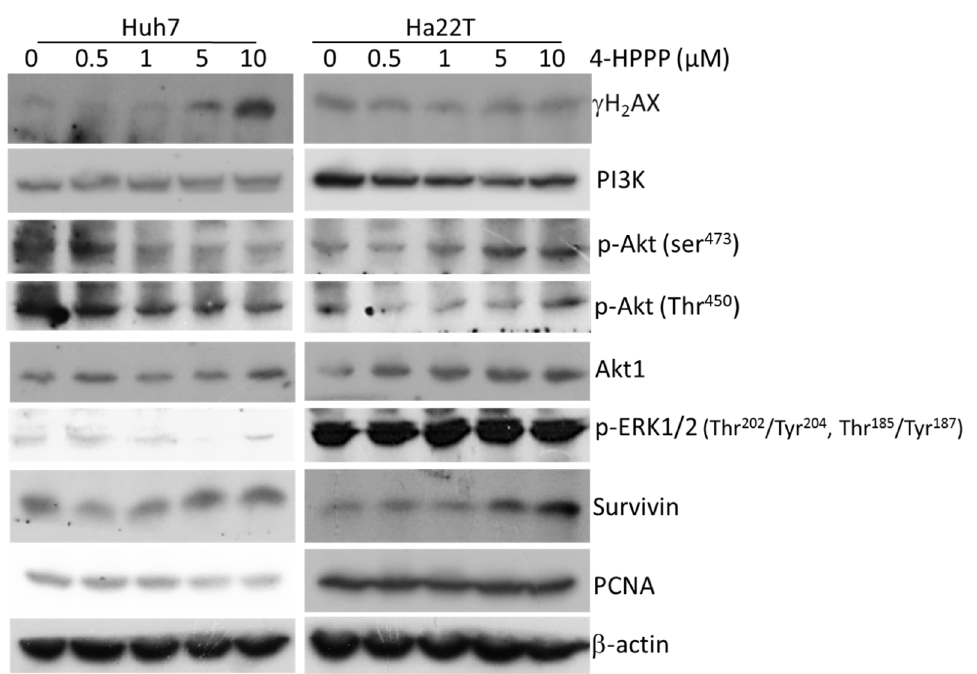
Figure 8. The changes of the survival-related proteins and DNA damage in 4-HPPP-treated HCC cells. Huh7 and Ha22T cells were seeded and treated with indicated concentrations of 4-HPPP for 24 h respectively. Afterward, cells were harvested and lysed. The protein lysates were resolved and analyzed by 10% and 12% sodium dodecyl sulfate-polyacrylamide gel electrophoresis (SDS-PAGE) and Western blot assay respectively. β -actin as an internal control for equal loading.